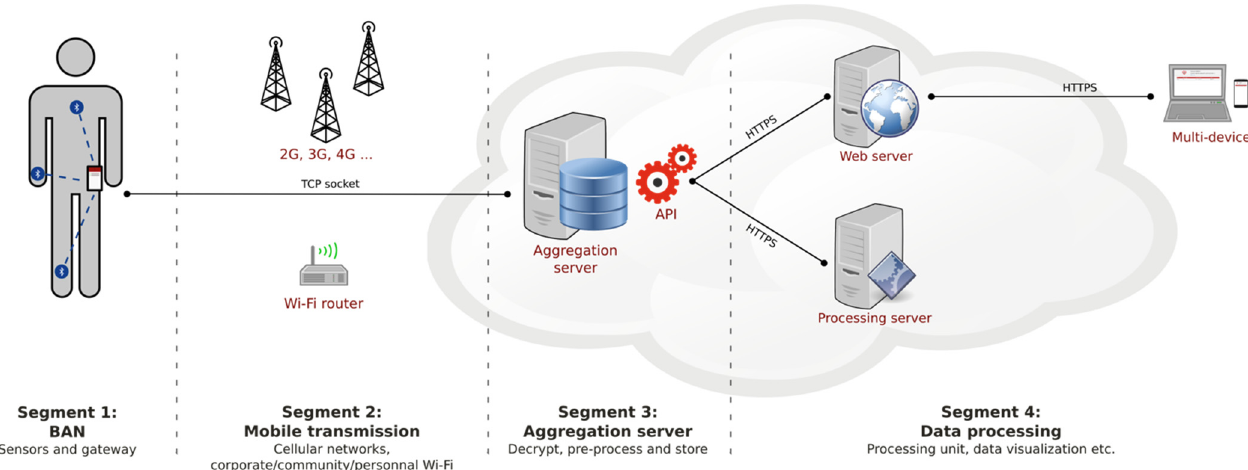
Figure 2. Synthetic view of the SHERPAM platform used in this study. The SHERPAM platform is a system device capable of transmitting a data stream to a remote server. A full description of the project and platform can be found at the following address, https://project.inria.fr/sherpam/ accessed on 20 September 2021, where project presentation, results, publications, and members are detailed.